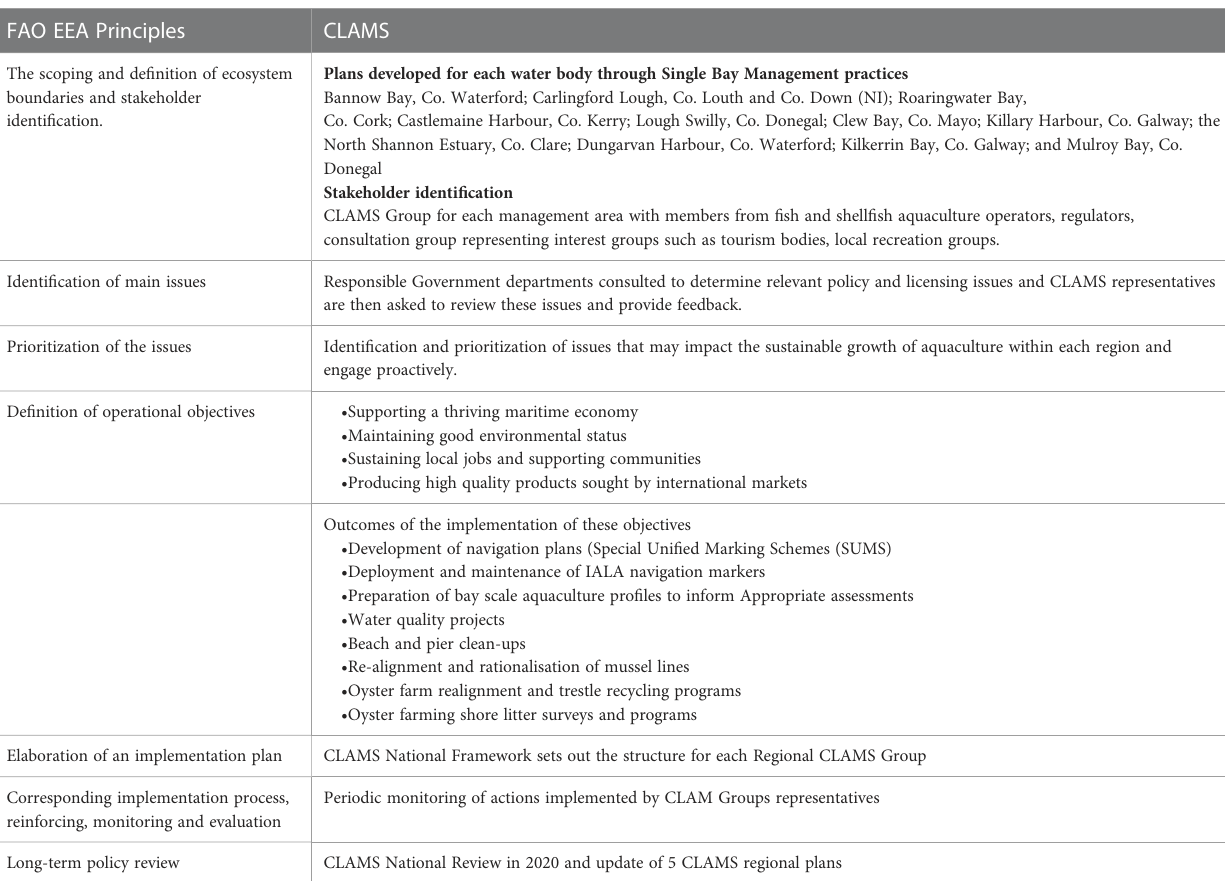
TABLE 7 Sustainable aquaculture